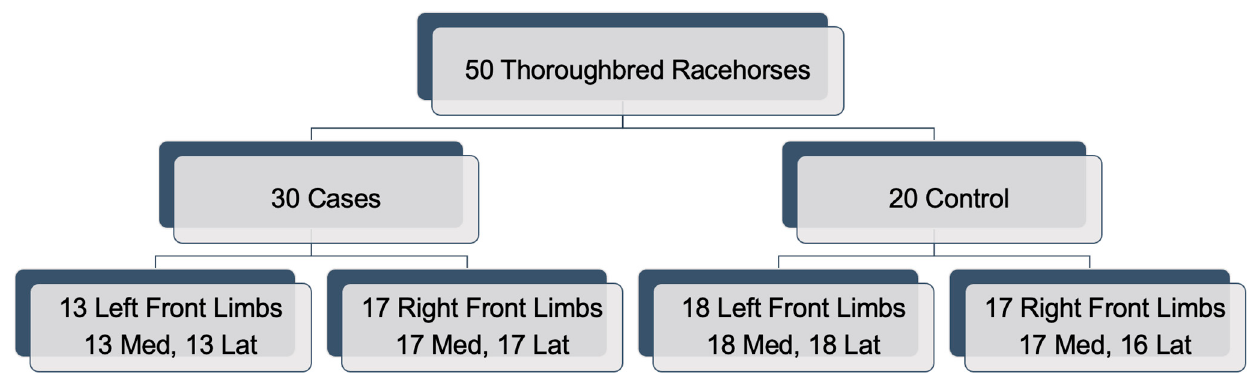
Figure 1. μ CT datasets analyzed in this study. “Med” and “Lat” refer to the medial and lateral prox- imal sesamoid bones in the